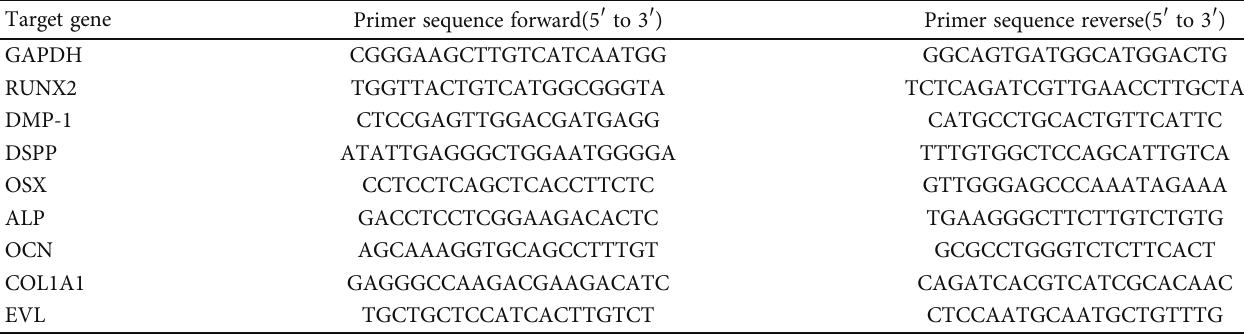
Table 1: RT-PCR primers for the target genes.